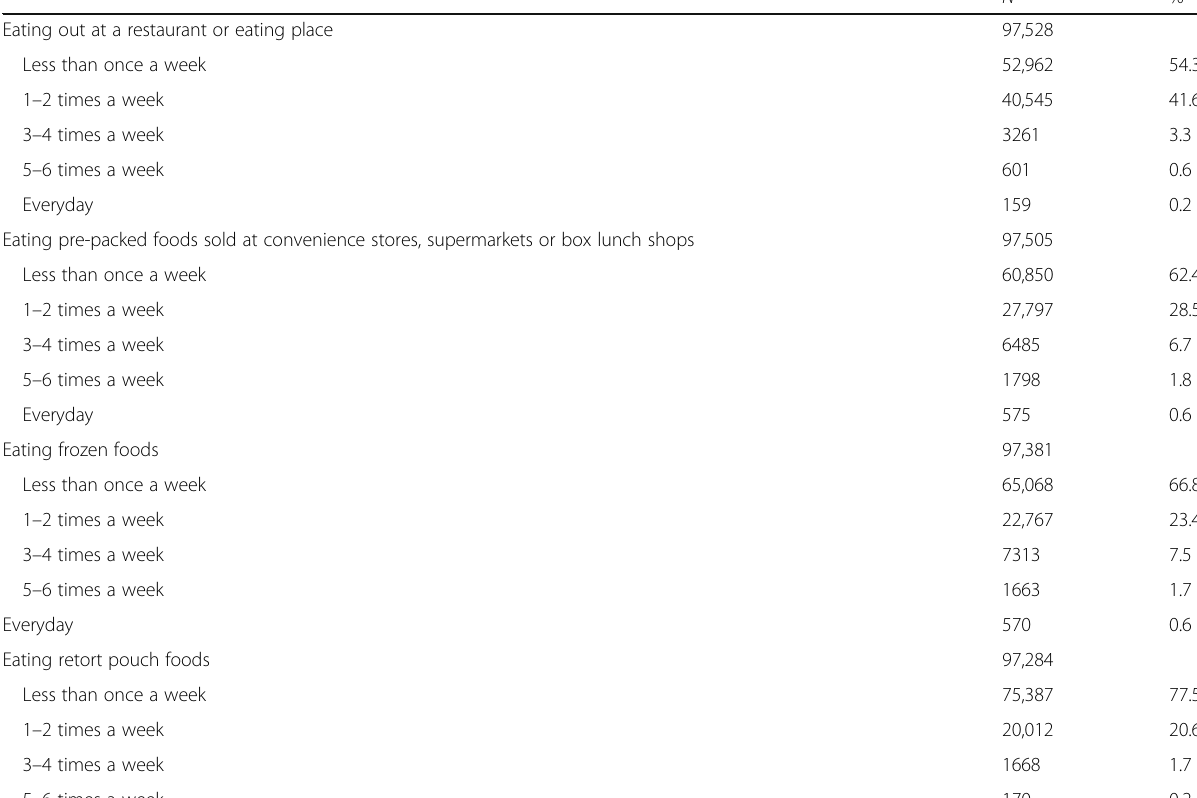
Table 4 Dietary habits during pregnancy for breakfast, lunch, or dinner during the last month